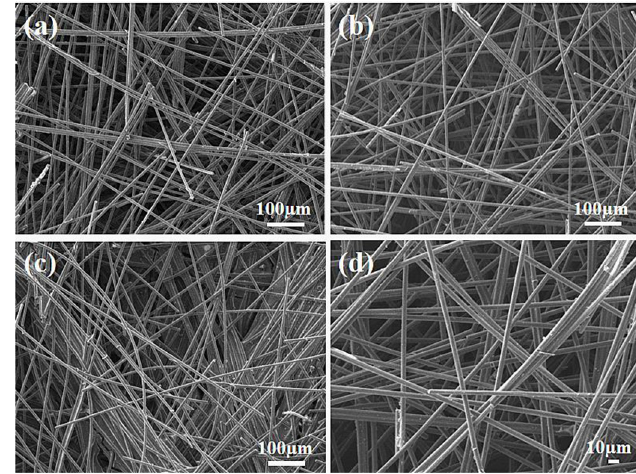
Fig. 3. The SEM images of CFS/AgNWs composites with different content of AgNWs. (a – d) represents 0, 1.37, 3.03 and 4.03 wt% content of AgNWs.